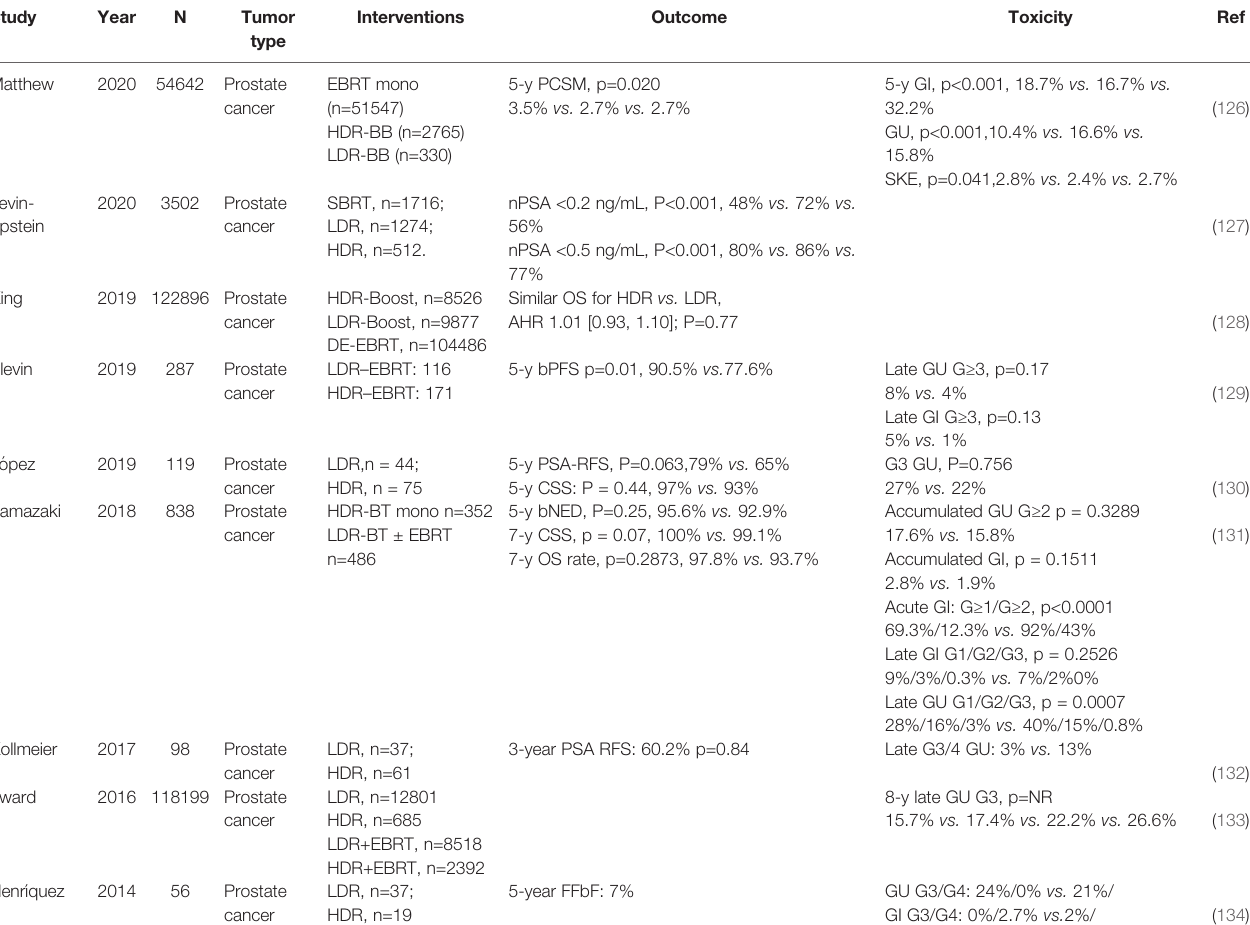
TABLE 4 | The comparison of oncological results of LDR and